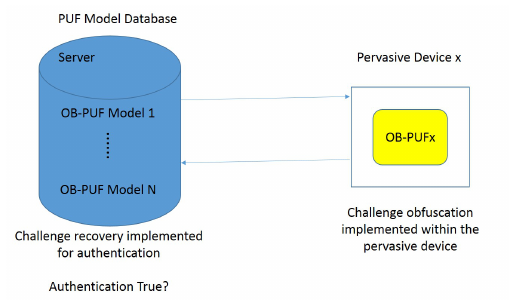
Figure 10. Obfuscated PUF structure. Adapted from